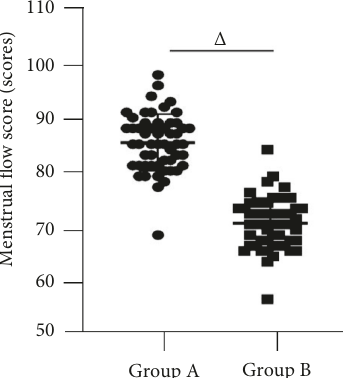
Figure 1: Duration of abdominal pain. Note . Δ indicates P < 0 . 005 for the difference between groups A and B.